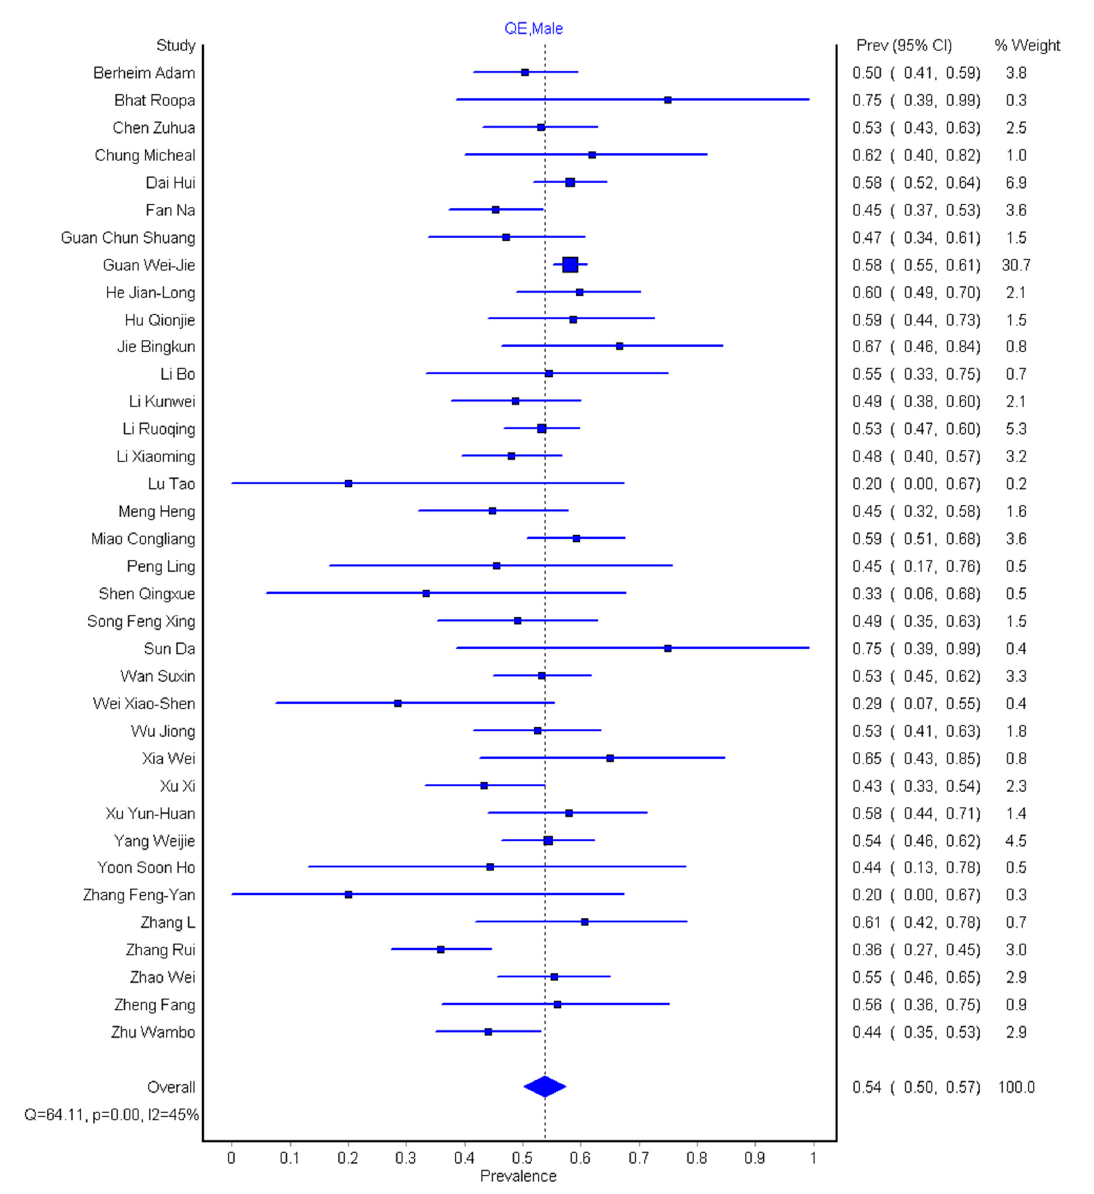
Figure A1. Forest plot of the pooled prevalence of male patients.